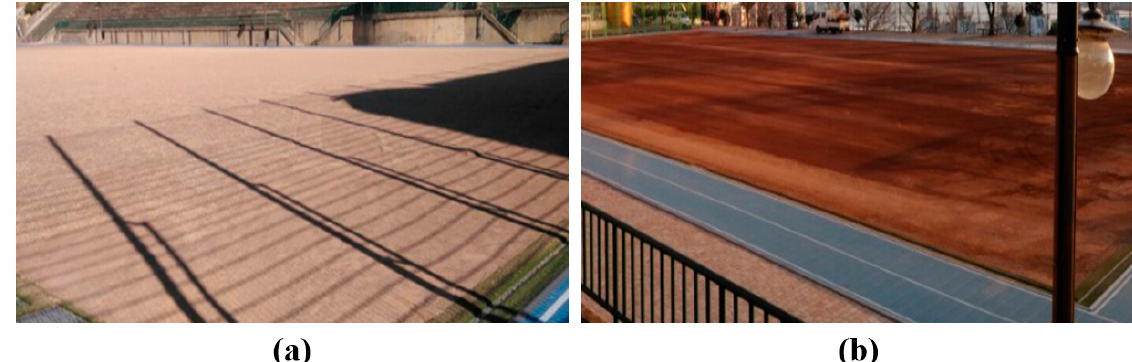
Figure 2. Site construction on K elementary playground using soil samples coated with 12% coating solution: ( a ) before coated soil was laid on the playground, ( b ) after coated soil was laid on the playground.